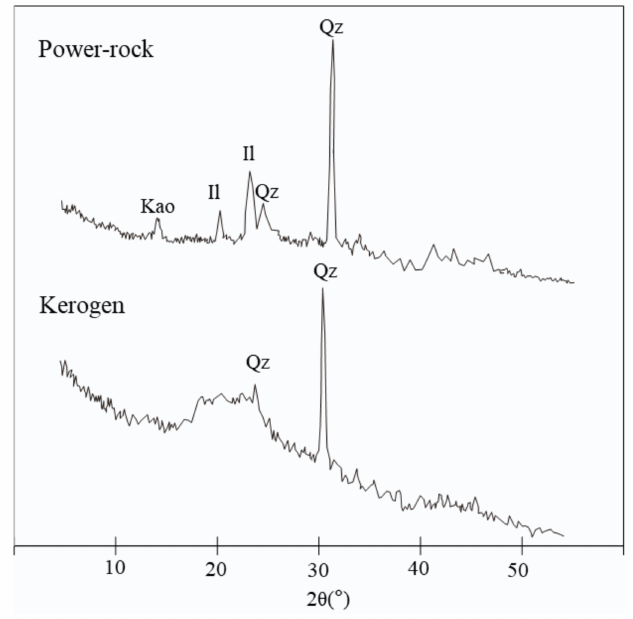
Figure 3. XRD spectra of powdered rock and kerogen of Maoming oil